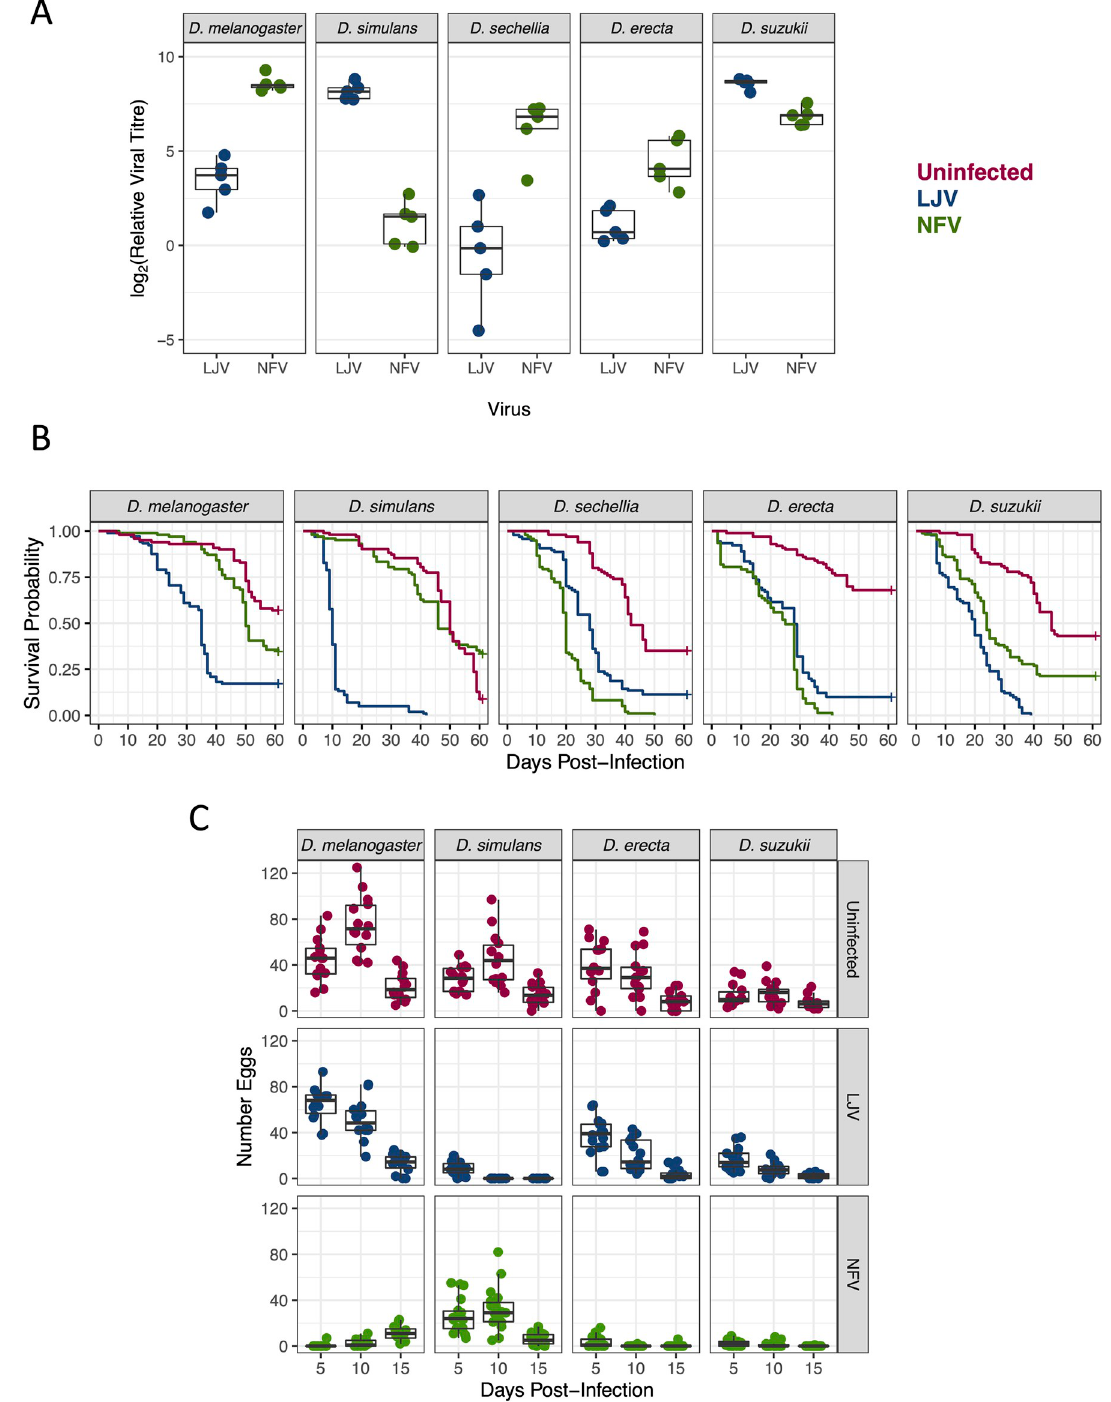
Fig 3. Host range and virulence of LJV and NFV. (A) Viral titre 4 dpi. Each point is a pool of 10–12 flies, and viral RNA levels are measured relative to RpL32 . (B) Survival of flies after viral infection. Each line is from a mean of 98 flies. (C) Egg production after infection. Each point is the number of eggs laid of two females over